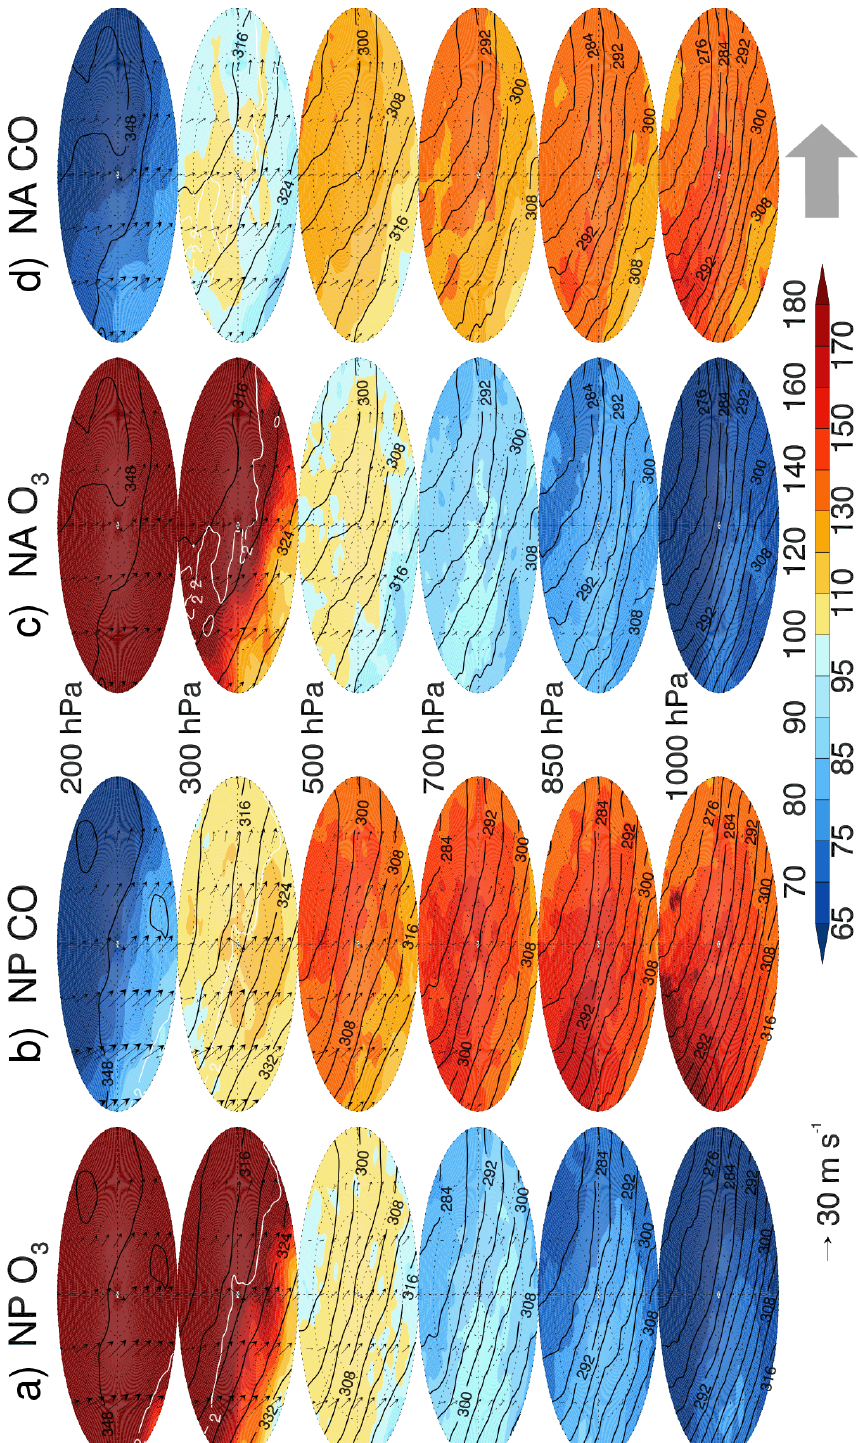
Figure 5. Same as Fig. 4 but for storm tracks with the background meteorology and